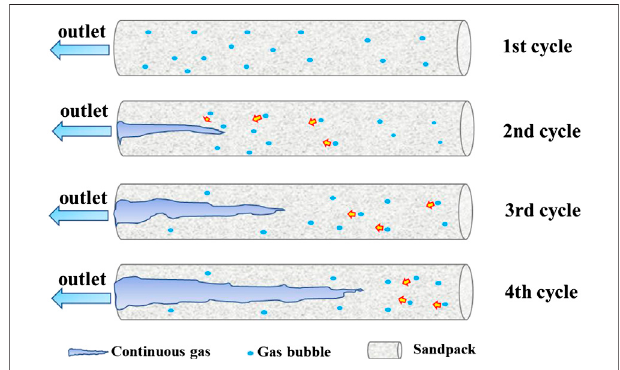
FIGURE 14 | Diagram of single sandpack N 2 huff-n-puff production process.